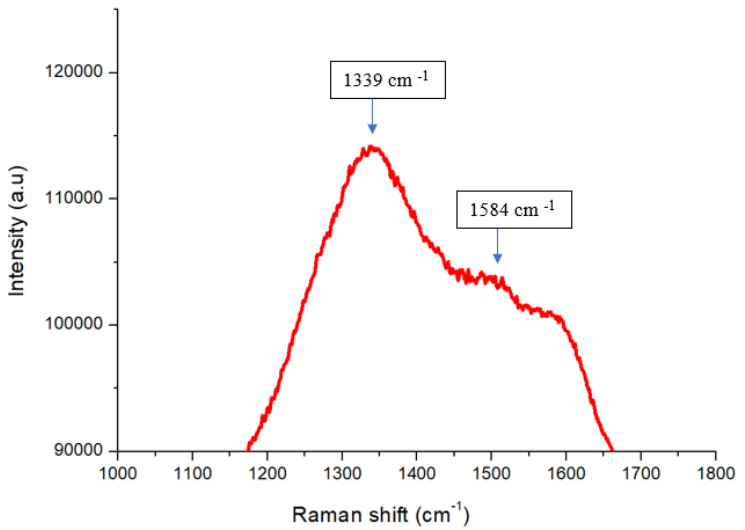
Fig. 2. Raman spectra of produced GO